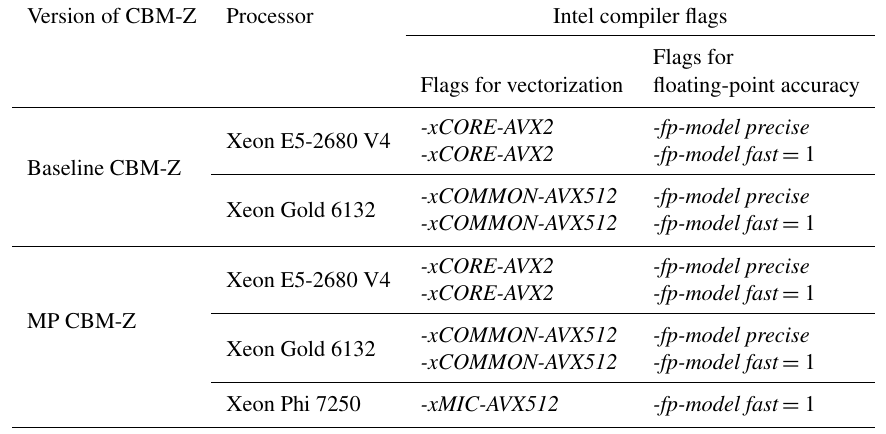
Table 2. Compile flags of the different versions of CBM-Z.